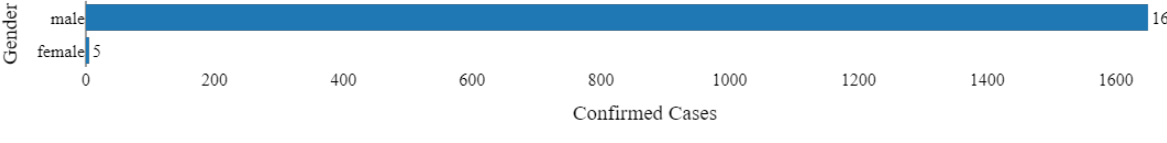
Figure 10. Summary of total confirmed cases according to